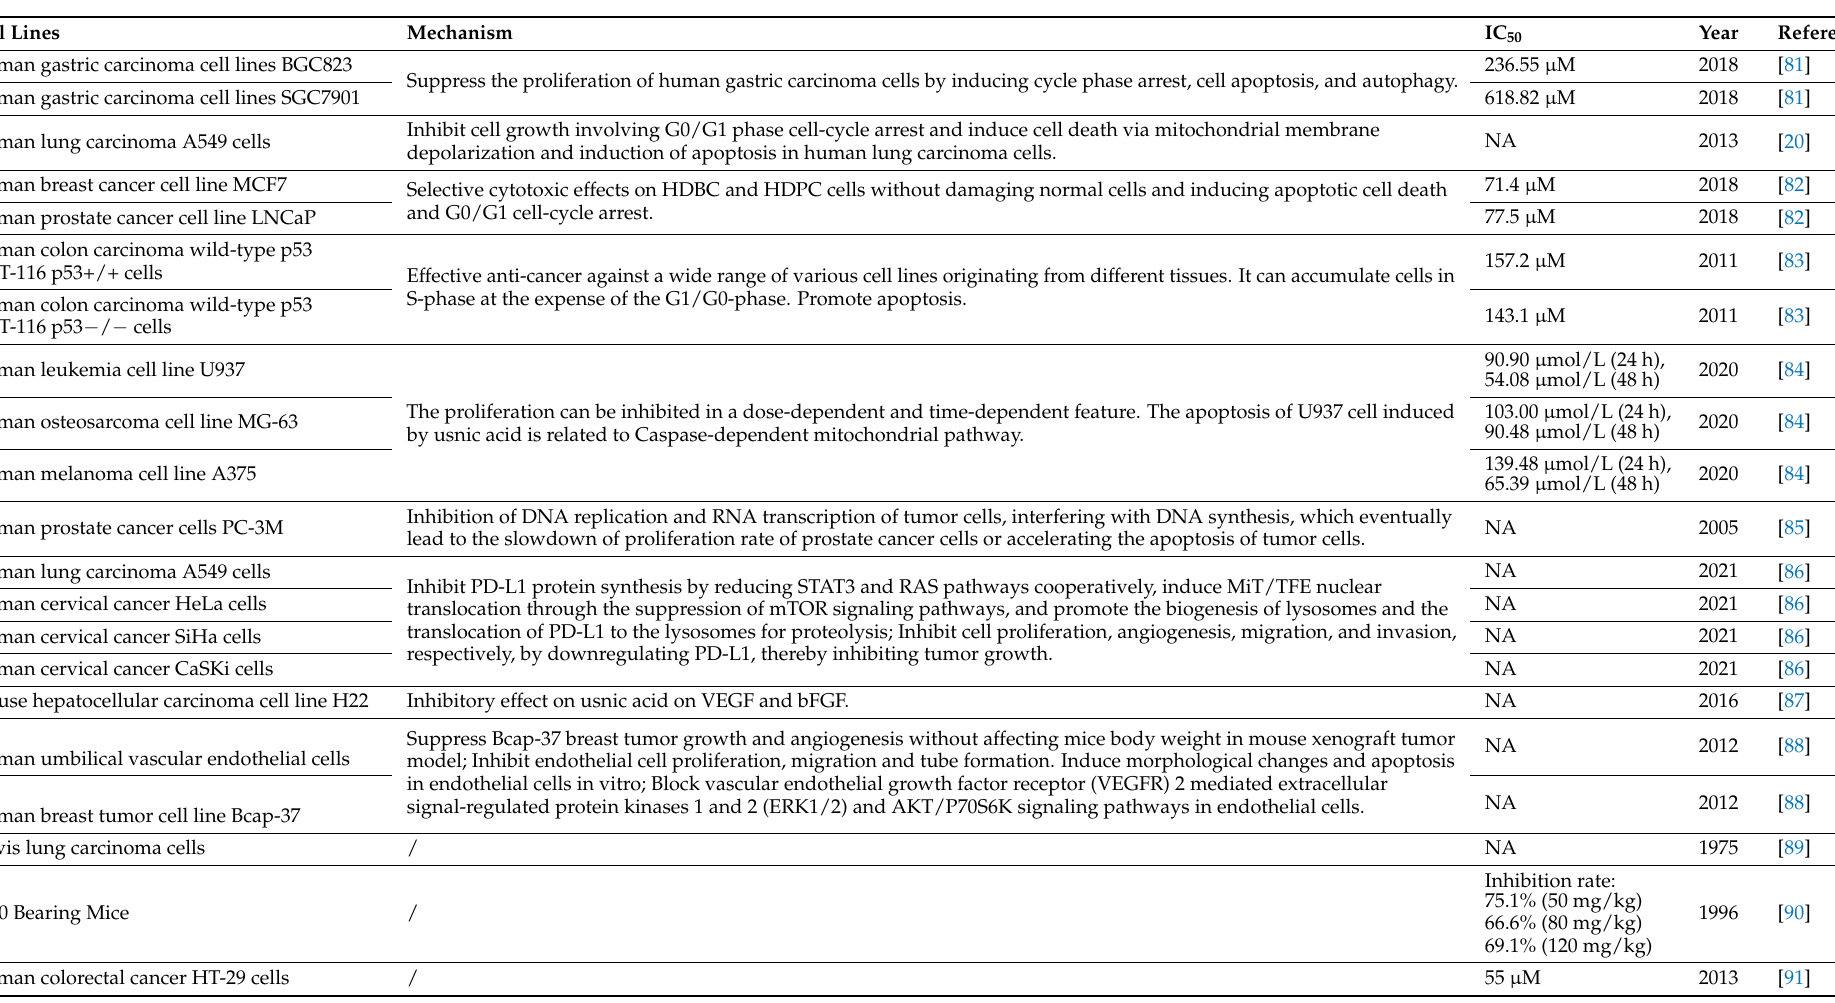
Table 3. Antitumor activities and mechanism of usnic